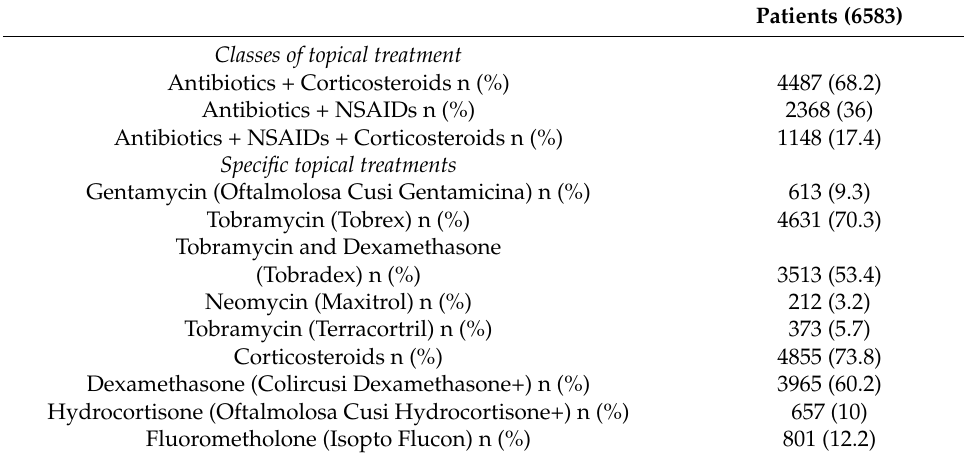
Table 4. Topical medications used for treating acute bacterial